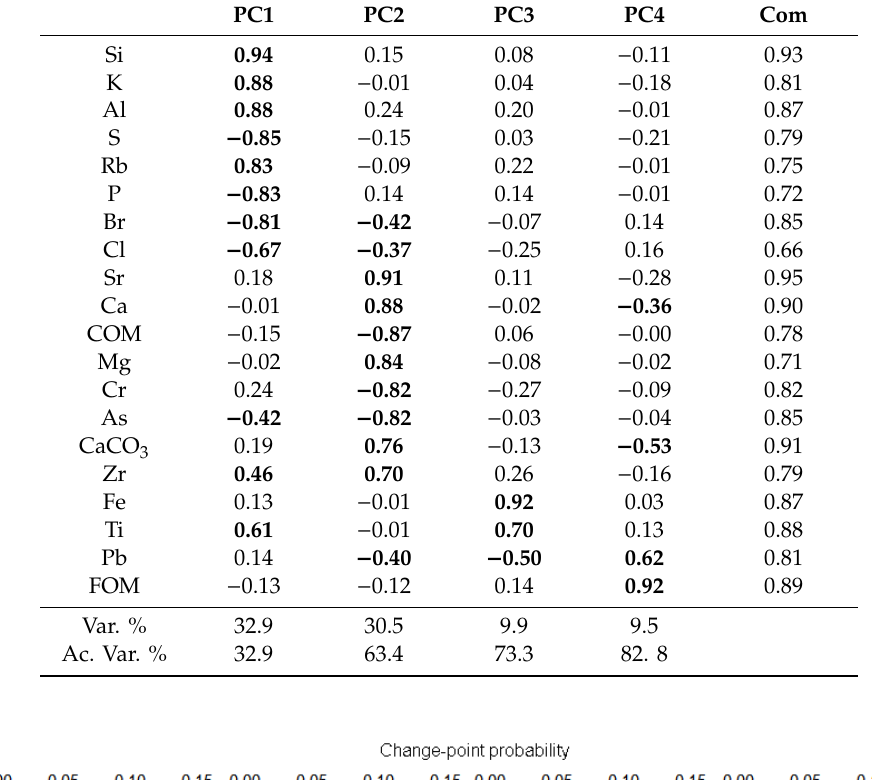
Table 1. Loadings of chemical elements, coarse organic matter (COM), fine organic matter (FOM) and carbonates for each component as yielded by the principal components analysis (PCA). Com: communality(totalvarianceofeachvariableexplainedbytheextractedcomponents), Var. %: percentage of variance accounted for by each component; Ac. Var. %: cumulative variance. Loadings > 0.35 in bold.